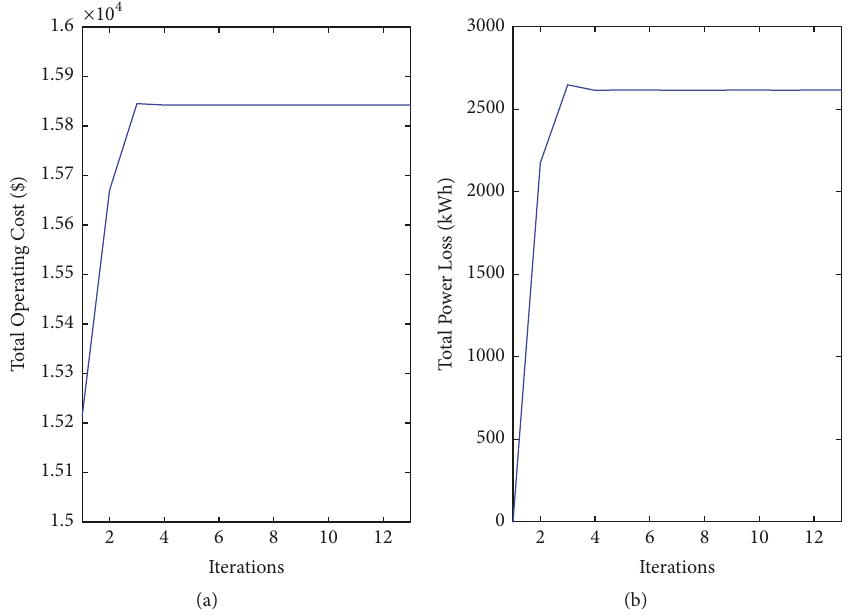
Figure 14: Evolution of (a) total operating cost and (b) total power loss over 24